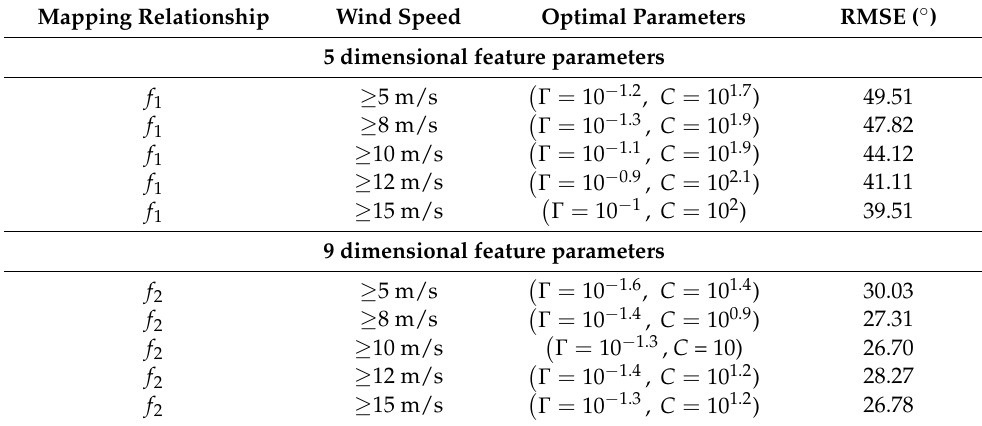
Table 3. SVM results of different wind speed datasets with two mapping relationships.